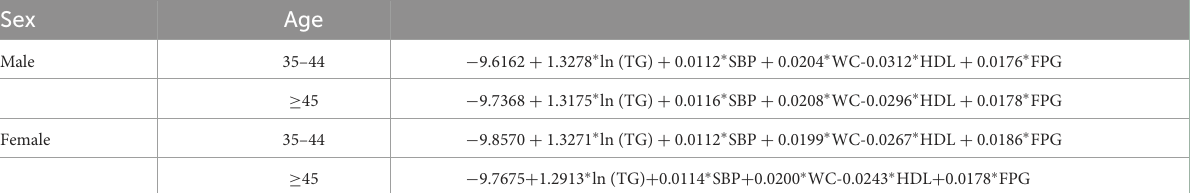
TABLE 2 Equations for sex- and age-specific metabolic syndrome risk